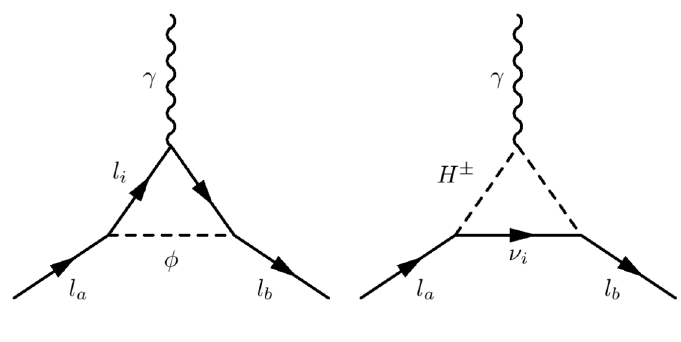
Figure 5 . One-loop diagrams contributing to ‘ → ‘ 0 γ with a neutral scalar diagram on the left and a charged scalar diagram on the right. The indices a, b, i correspond to any of the lepton flavours e, µ, τ , and we have φ = h, H, A .